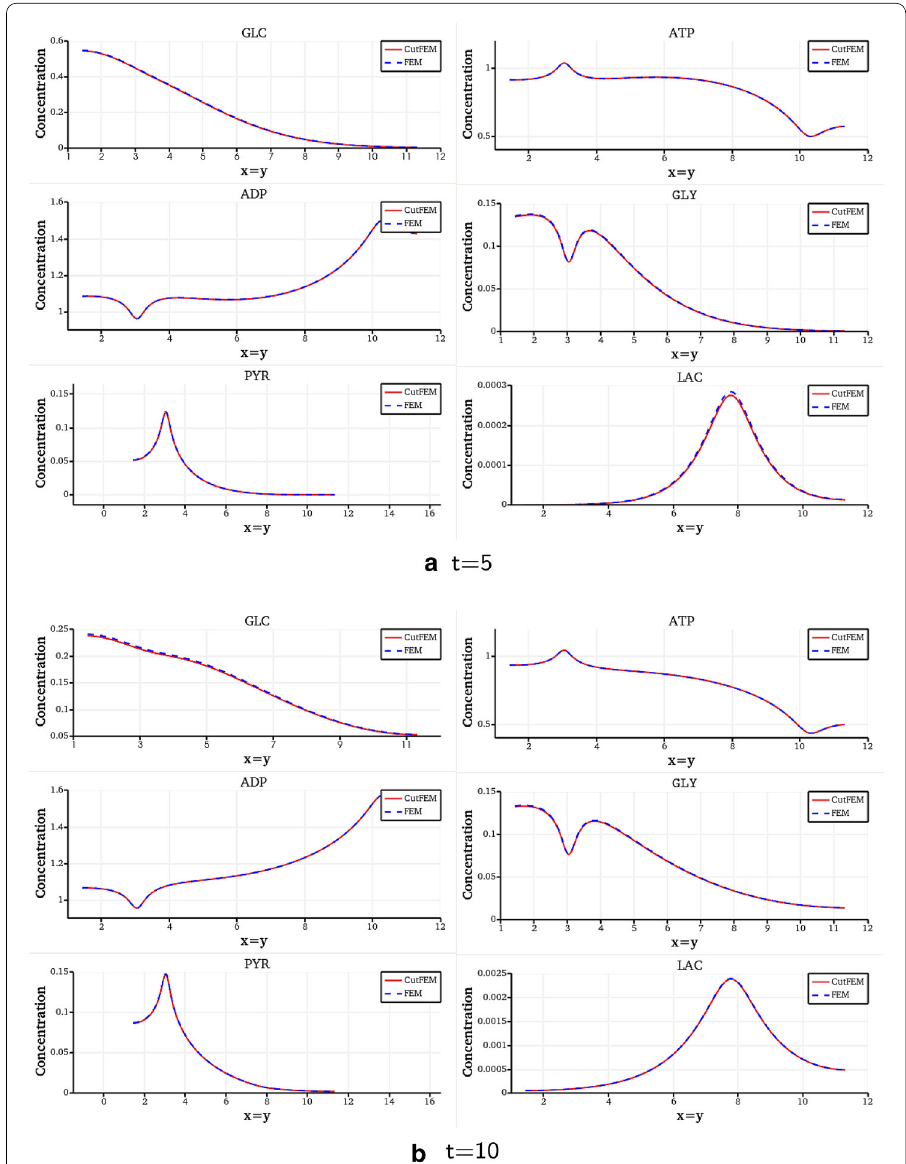
Fig. 8 We plot the solutions of the concentrations in a circular domain obtained with FEM and CutFEM along the line x = y at time t = 5 ( a ) and final time T = 10 ( b ). We can notice in the plot the location where the reactions are happening thanks to the bump in the plot. The only small differences detectable are in LAC at t = 5 and in GLC at t = 10 where CutFEM is slightly below the FEM curve